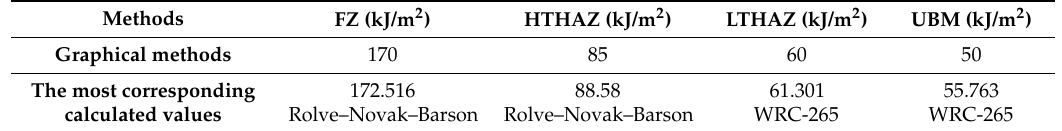
Table 7. The critical fracture resistance (J IC ) comparison